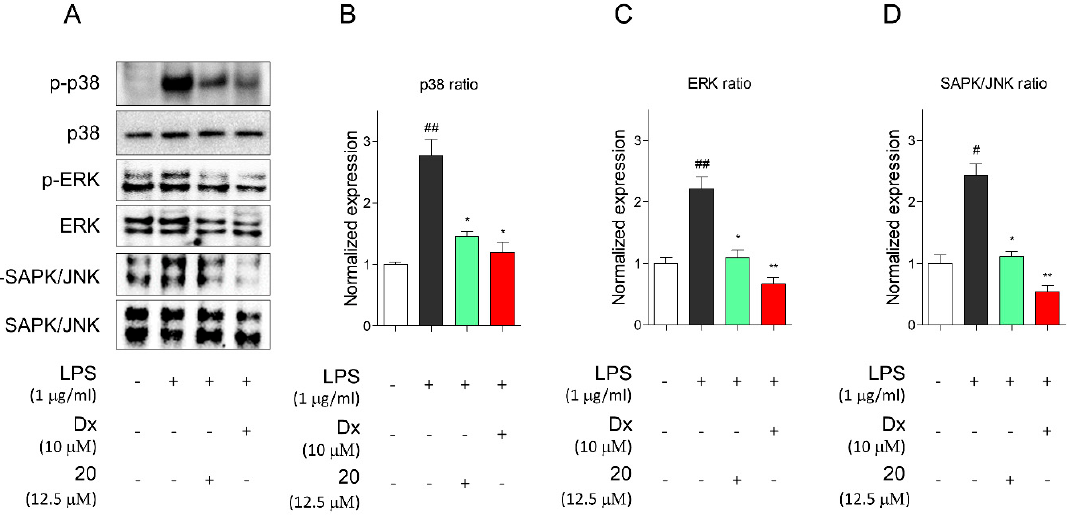
Figure 5. Compound 20 suppressed MAPK signaling pathway. ( A ) Immunoblot analysis showed that phosphorylated protein levels of MAPKs pathway, p38, ERK, and JNK were inhibited by compounds 20 in RAW 264.7 macrophages. ( B – D ) The graphs represent ratio of protein level of p38 ( B ), ERK ( C ), and JNK ( D ). Cells were preincubated for 2 h with compound 20 at concentration of 12.5 µ M and stimulated with LPS (1 µ g / mL) for 1 h. Dexamethasone served as positive control. Immunoblot analysis performed as triplicate experiments, and data represented as means ± SEM. Significant di ff erence was considered at the levels of # p < 0.05 and ## p < 0.01 versus Con, * p < 0.05 and ** p < 0.01 versus LPS. Con: control, LPS: lipopolysaccharide, Dx: dexamethasone.